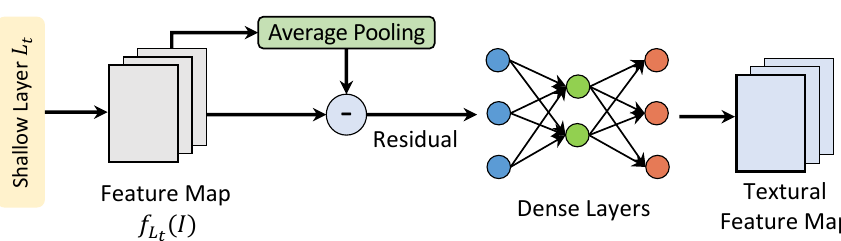
Figure 3. Texture-aware residual block helps preserve and enhance the texture information of shallow feature maps at layer L t through average pooling, feature-level residuals, and densely connected convolution layers.